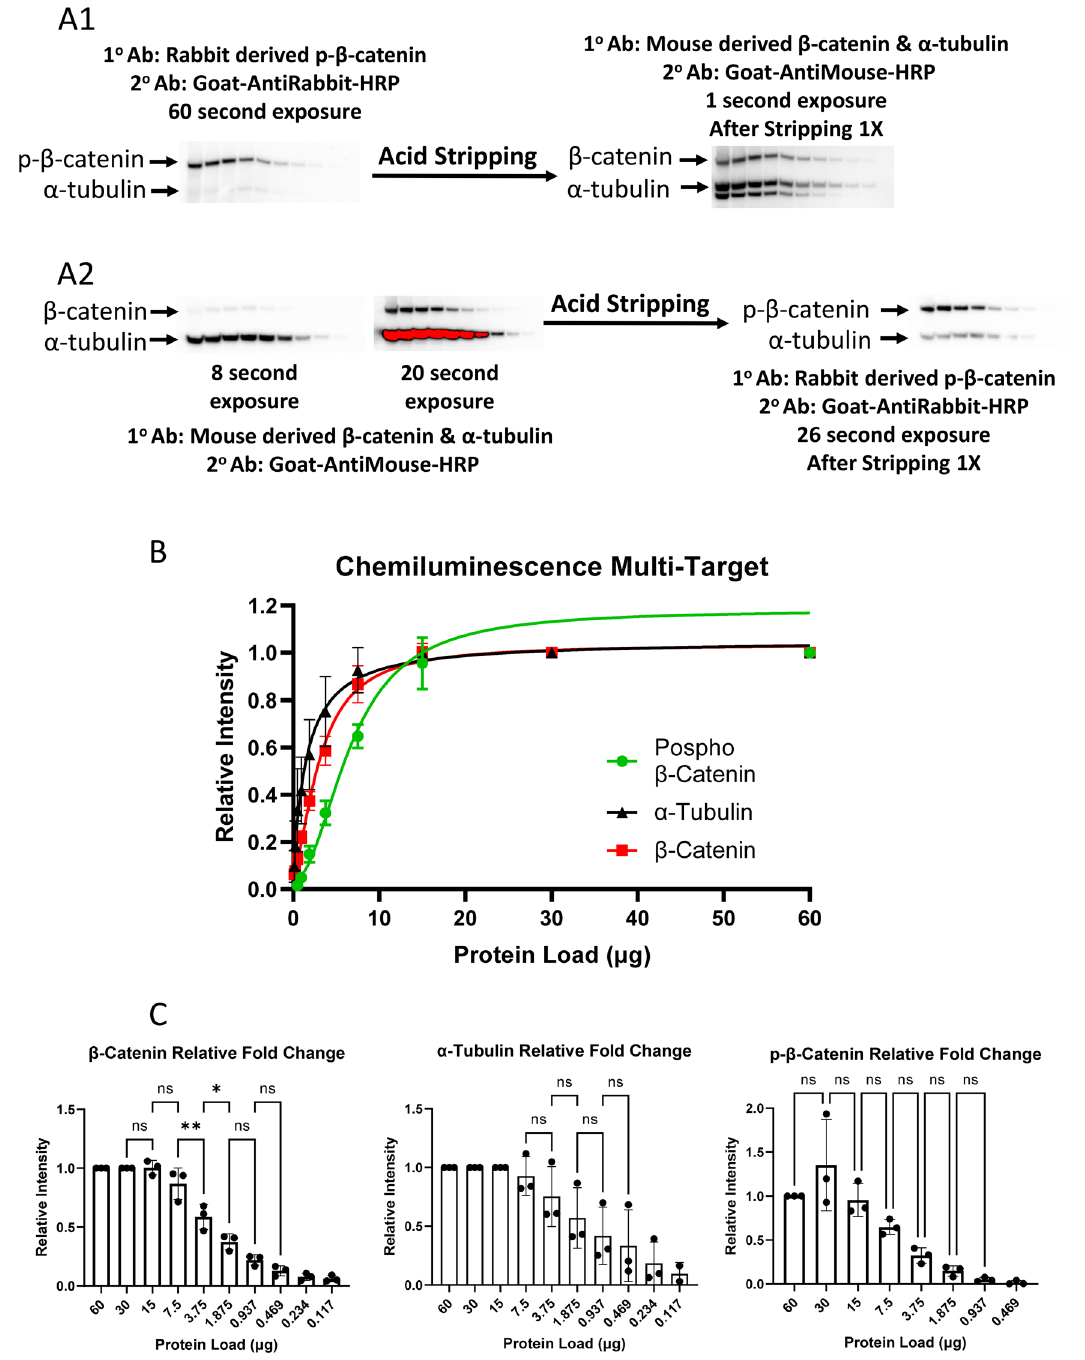
Figure 2. Chemiluminescence data analysis. The identical three blots assessed by fluorescence (Fig. 1) were also analyzed by chemiluminescence. The membranes were probed with a mixture of three primary antibodies against β-catenin, phospho-β-catenin (p-β-catenin) and α-tubulin followed by a solution of mixed fluorescent and chemiluminescent secondaries (see "Methods" section). ( A1 ) Chemiluminescent signal from p-β-catenin followed by membrane stripping and probing for β-catenin and α-tubulin. ( A2 ) Chemiluminescent signal from β-catenin and α-tubulin followed by membrane stripping and probing for p-β-catenin. ( B ) Plot of the average relative density versus protein load from the combination of both unstripped and stripped membranes (error bars represent the SEM from the average of three, separate experiments). ( C ). Bar charts depicting the average, relative signal intensity versus protein load for the three experiments from both unstripped and stripped membranes (error bars represent the standard deviation (SD) from the average of three, separate experiments). The statistical difference between each level of protein load is shown where: ** p -value < 0.0021; * p -value < 0.0332; ns non-significant. Full blot images for ( A ) are provided in the supplemental data (Supplemental Fig.